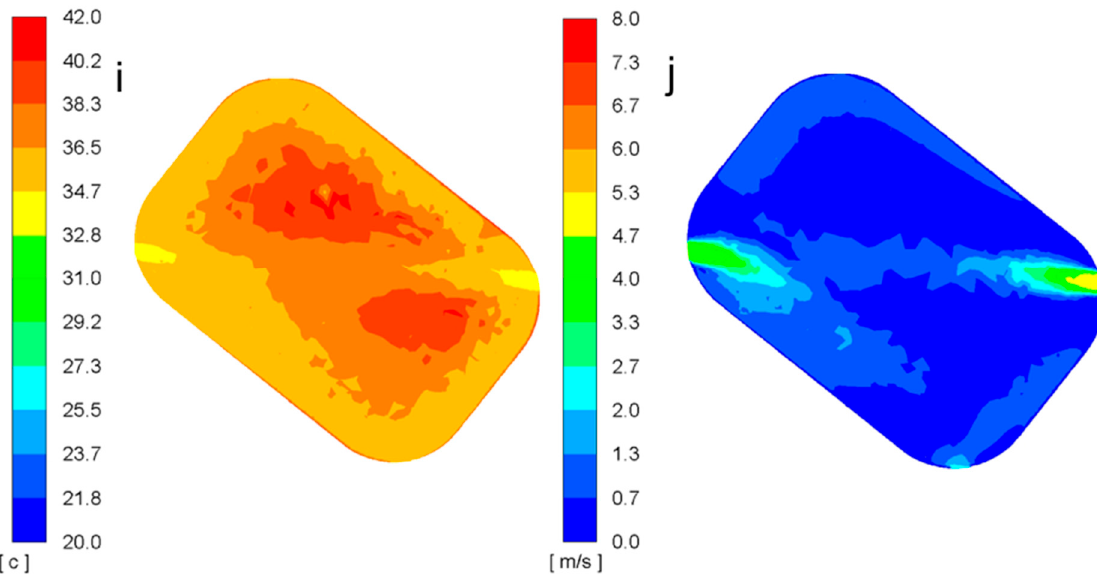
Figure 12. ( a – d ) Temperature distributions of the cross-section of the stadium for configurations 1–3 and the baseline configuration. ( e – h ) Wind velocity distributions of the cross-section of the stadium for configurations 1–3 and the baseline configuration. ( i ) Temperature distributions of the pitch for the baseline configuration. ( j ) Wind velocity distributions of the pitch for the baseline configuration.